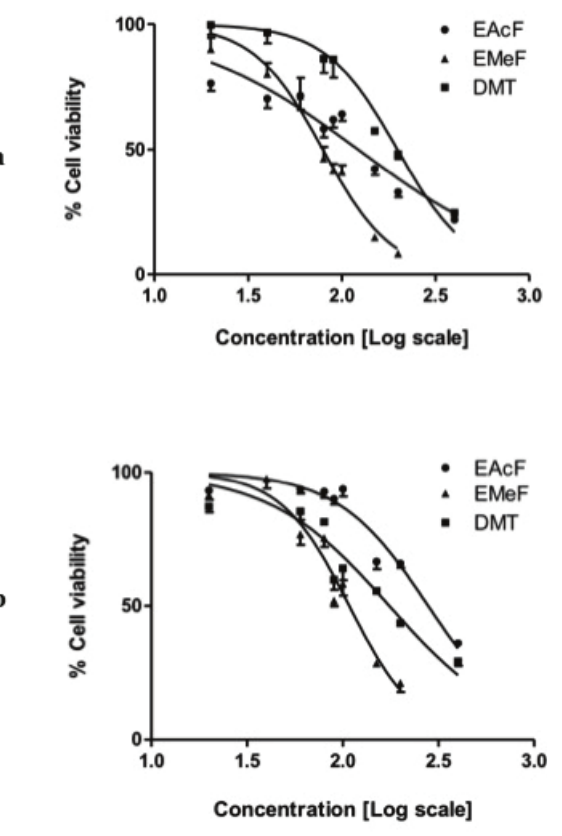
Figure 2 - Representative curves of surviving B16F10 (A) and 4T1 cells (B) versus log of concentration (µg/mL) of EAcF, EMeFand DMT, isolated from leaves of P. viridis . The IC50 value was evaluated by means of non-linear regression (n = 5).